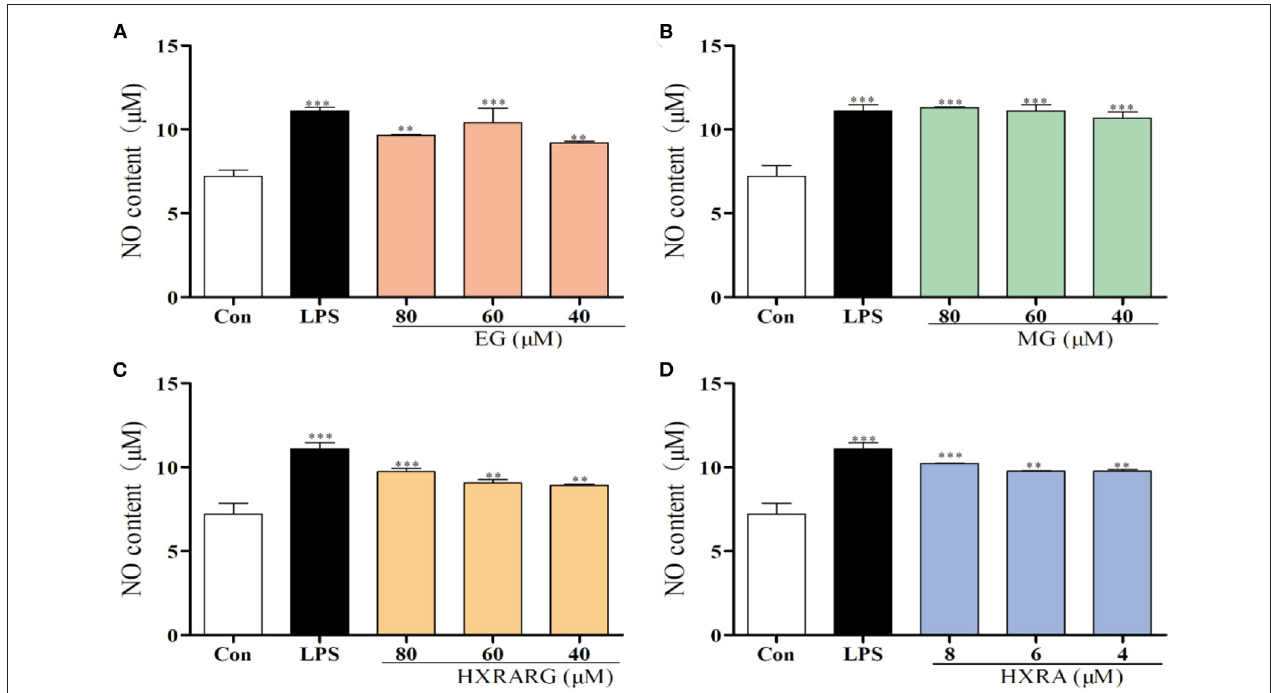
FIGURE 4 | Effects of EG (A) , MG (B) , HXRARG (C), and HXRA (D) on nitric oxide (NO) production in RAW264.7 cells. Data are expressed as the means ± SD. Compared with the control, ** P < 0.01, *** P <